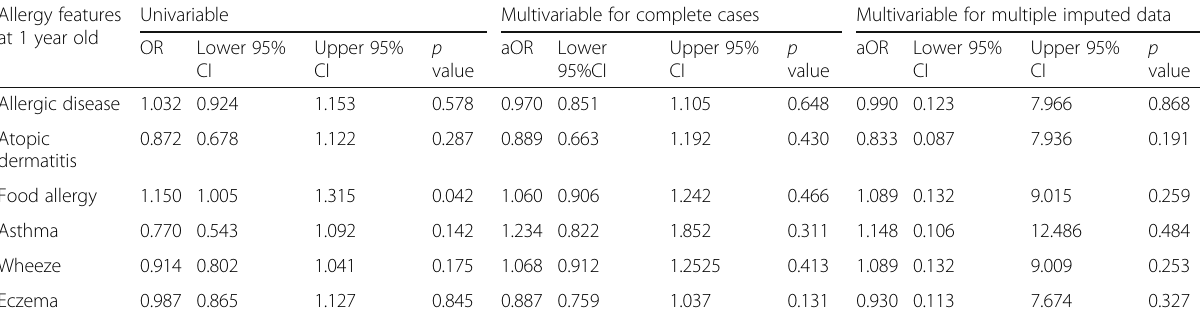
Table 5 Results of univariable and multivariable logistic regression for allergic features associated with initial live polio vaccine only compared with initial BCG vaccine only, in the JECS birth cohort (RQ3) Allergy features at 1 year